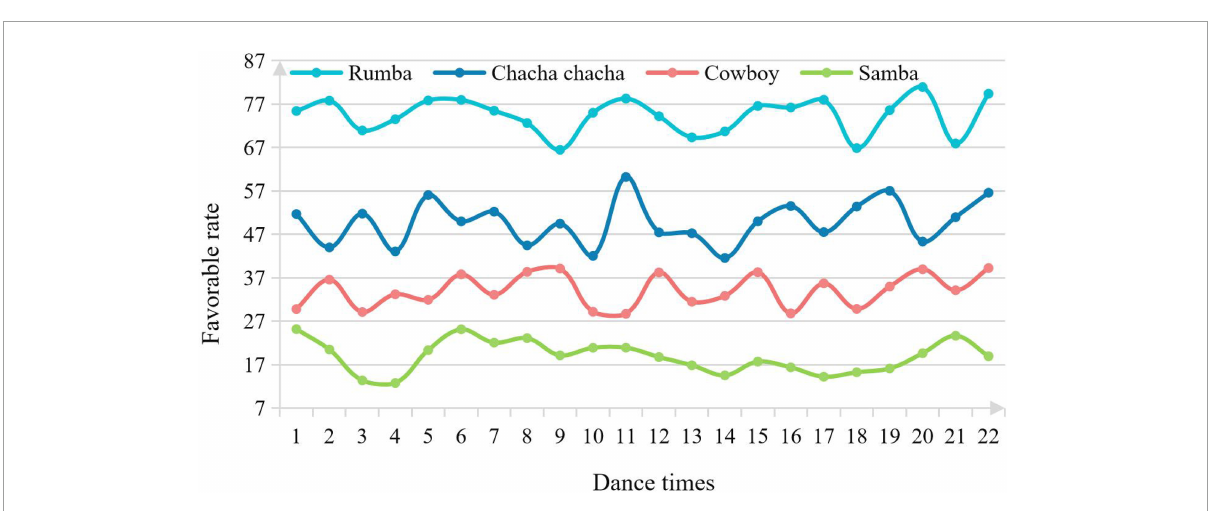
FIGURE4 Education level of parents.